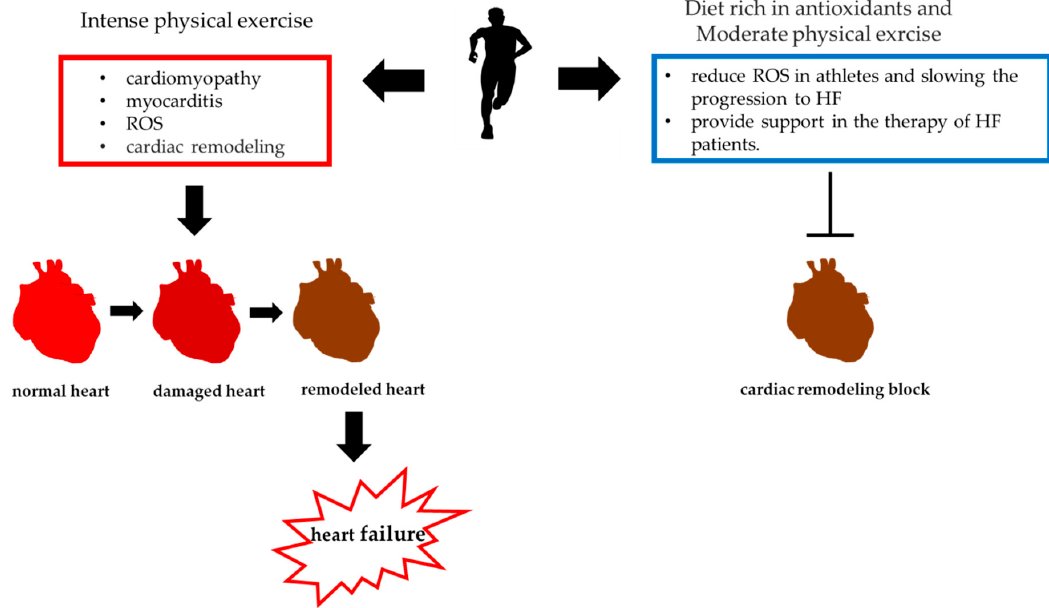
Figure 4. The role of intense physical exercise in heart failure .